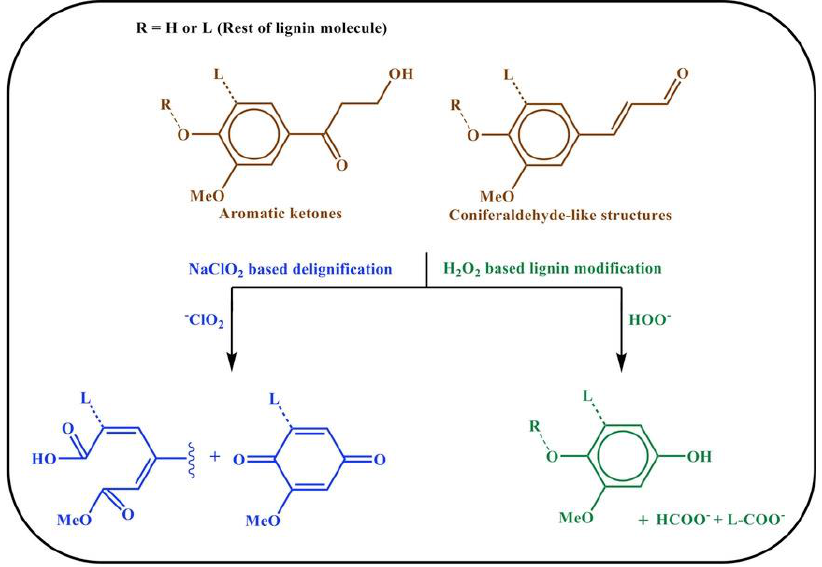
Figure 5. Representative reactions in delignification and lignin modification processes. Reprinted with permission from [31], copyright 2017, John Wiley & Sons.